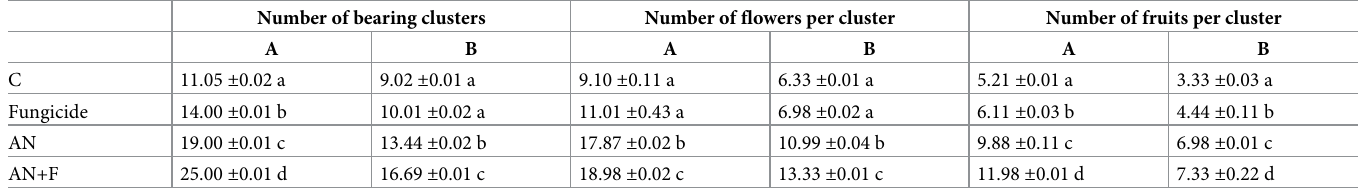
Table 7. Effect of A . nodosum extract application on plant yield parameters: Field-grown tomato (A) and sweet pepper (B).